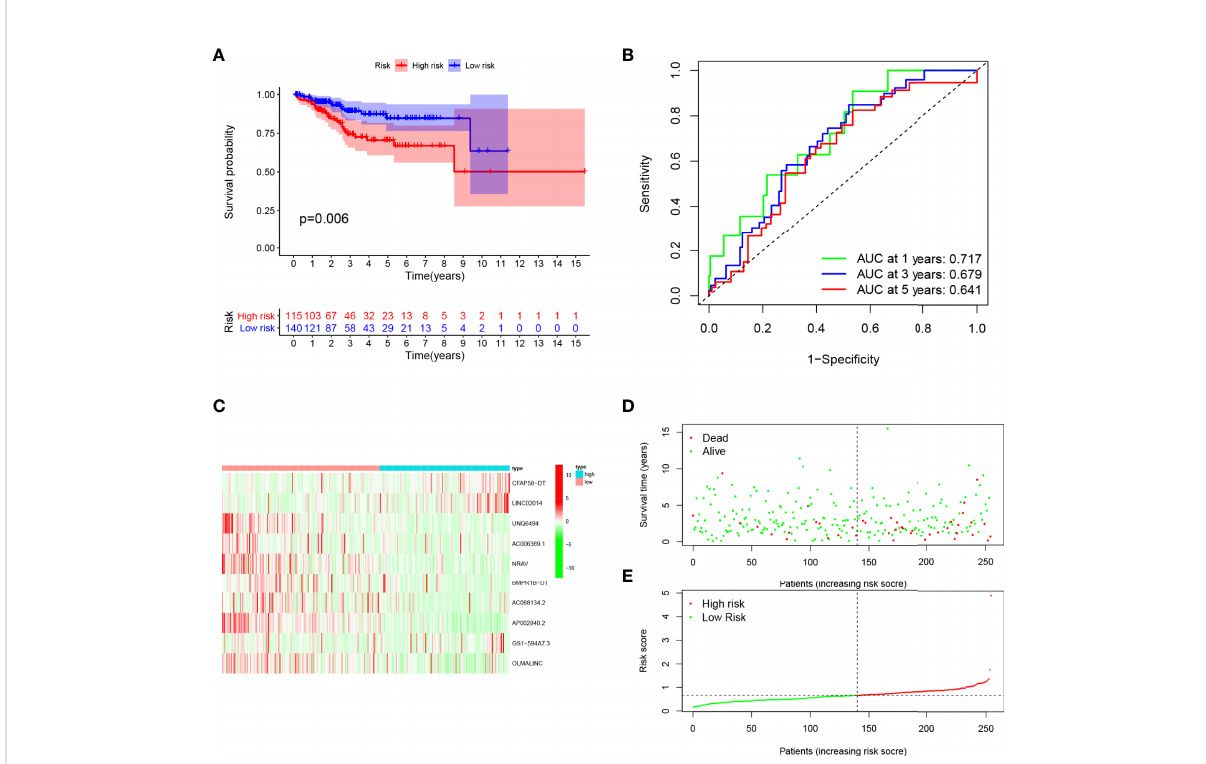
FIGURE 5 Evaluation of the prognostic value of this signature in validation cohort. (A) Survival analysis showed a worse prognosis in the high-risk group ( p = 0.006). (B) The 1-, 3-, and 5-year area under the curve (AUC) values of the signature are 0.717, 0.679, and 0.641, respectively. (C) Expression heatmaps of 10 lncRNAs in signature. (D, E) Survival status and risk score status of validation